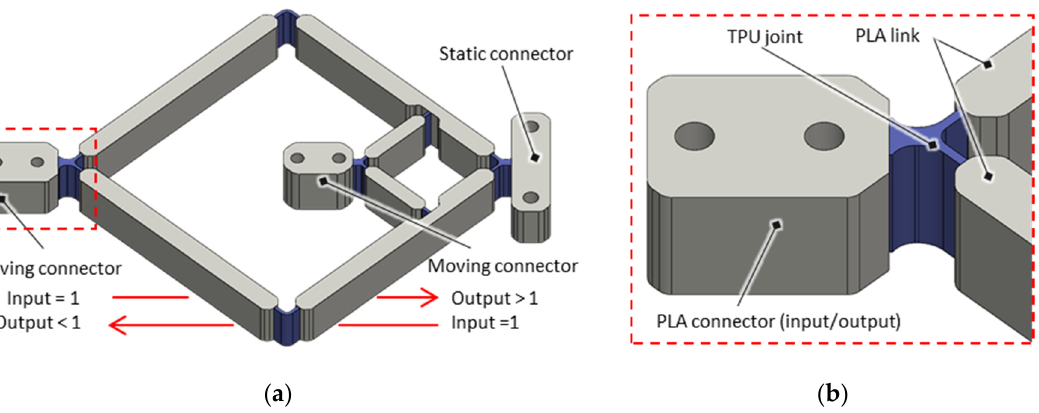
Figure 7. ( a ) CAD of one-piece scissor linkage mechanism with a non-inversing transmission con- figuration, where input and output sides can be swapped, and ( b ) detailed view of the design of a TPU joint and PLA connector and